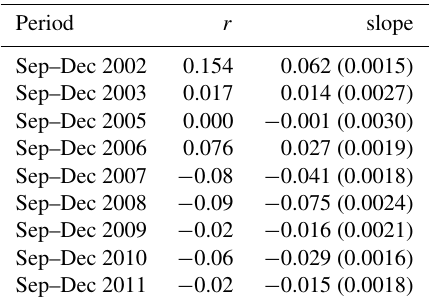
Table 3. Results of a correlation analysis between MIPAS OCS and simultaneously measured HCN for the latitude band between 50 ◦ S–0 ◦ N and the altitude range 10–14km during southern hemi- spheric biomass burning seasons of subsequent years; r : correlation coefficient; slope: slope of the regression line, the values in paren- theses are the 1 σ uncertainties. Period r